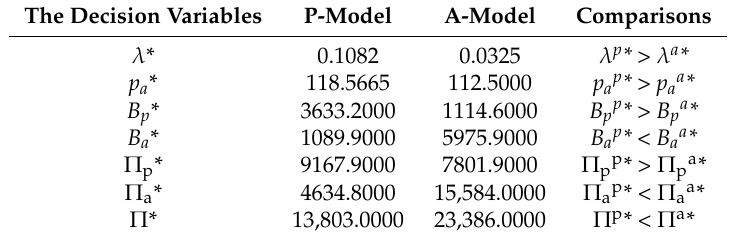
Table 1. Optimal equilibriums and profits of the platform and the advertiser in two models in Exp. 1. The Decision Variables